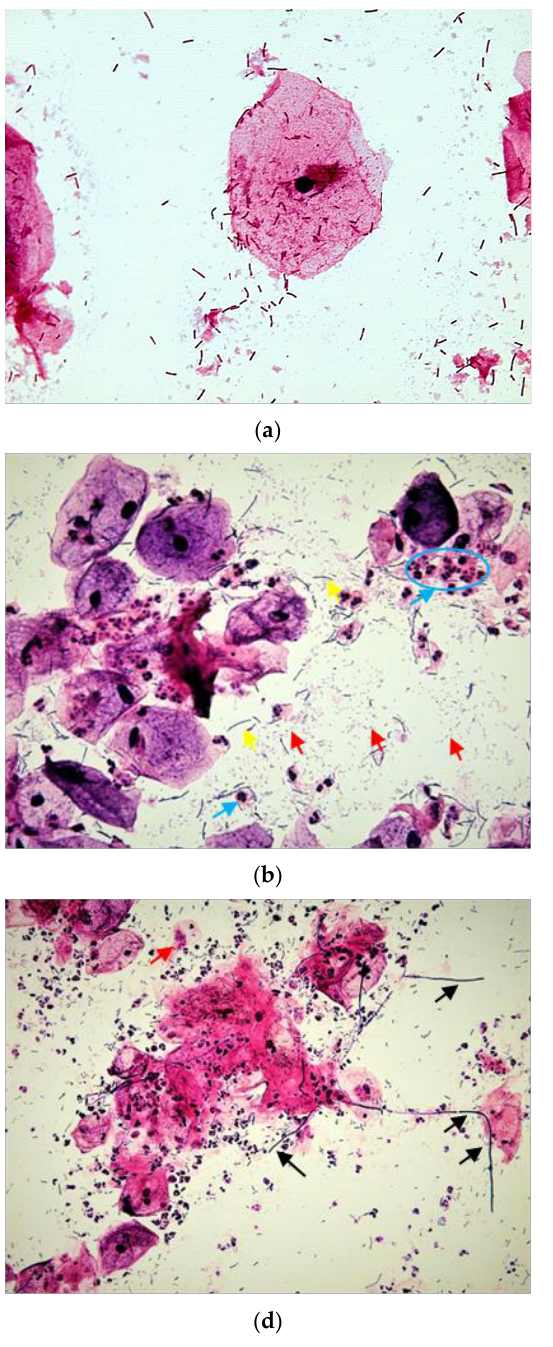
Figure 1. Microscopic images of vaginal smears after Gram staining. ( a ) Normal vaginal flora, a typical superficial cell, and healthy-appearing lactobacillus flora without leukocyte response. ( b ) Typical aerobic vaginitis flora (AV). Phase-contrast image in 400× magnification. ( c ) AV image in 1000× magnification. The yellow arrows indicate Lactobacilli spp. bacteria grade II b . The red arrows indicate the presence of small bacilli (Enterobacteria-like bacteria) or orange circle shows cocci in pairs. The blue arrows indicate leukocytes in toxic form (+10/cell). The green arrows indicated clue cells. Bacteria cover superficial epithelial cells and give them a specific blurry appearance. ( d ) AV mixed with candidosis; phase-contrast image in 400 × magnification. ( e ) Image in 1000 × magnification. The yellow arrows indicate Lactobacilli spp. bacteria; orange arrows and circle indicate cocci in pairs or in chain. The blue arrows indicate leukocytes in toxic form (+10/cell). The red arrows indicate cytolysis of epithelial cells. Hyphal forms of candidiasis are seen on black arrows.